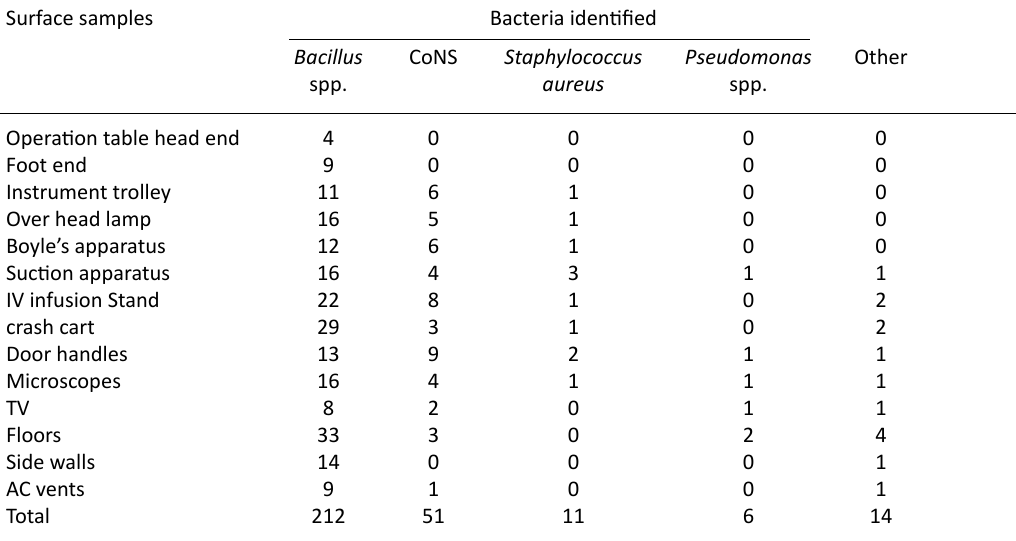
table 3. Bacteria isolated from various sites and equipment Surface samples